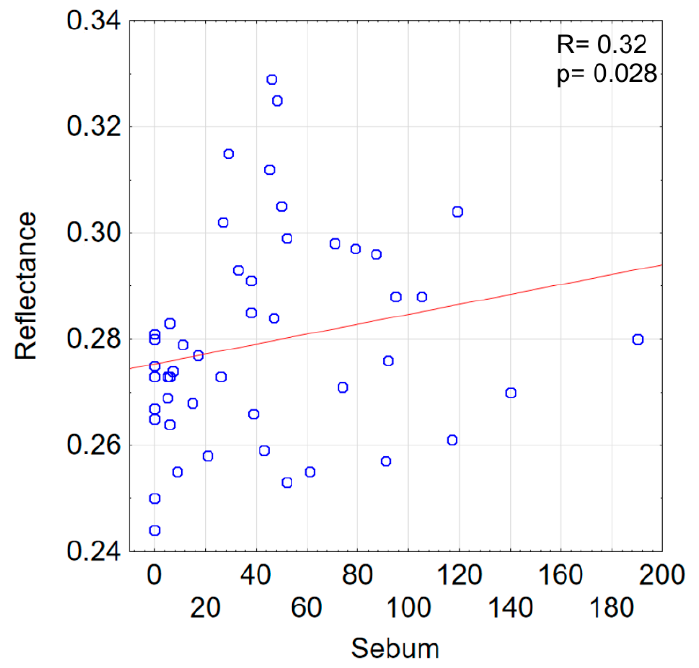
Figure 8. Correlation of sebum and skin reflectance at the wavelength 1000–1700 nm. Red line—trend line.